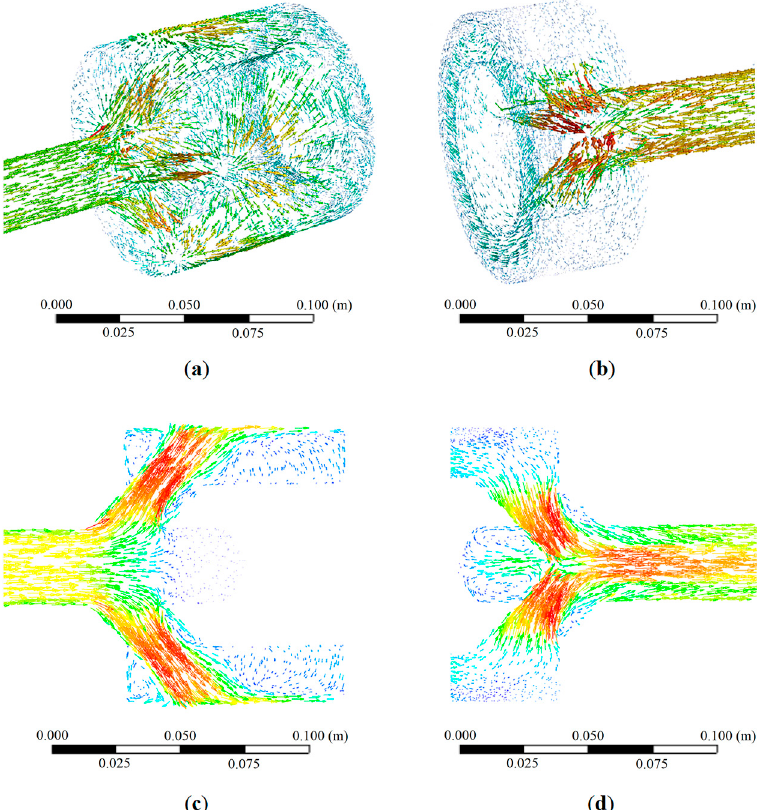
Figure 10. Velocity vector results at the inclined hole areas: ( a ) overview of the velocity vector result at the upper (inlet) inclined hole area; ( b ) overview of the velocity vector result at the lower (outlet) inclined hole area; ( c ) cross-sectional view of the velocity vector result at the upper (inlet) inclined hole area; ( d ) cross-sectional view of the velocity vector result at the lower (outlet) inclined hole area.